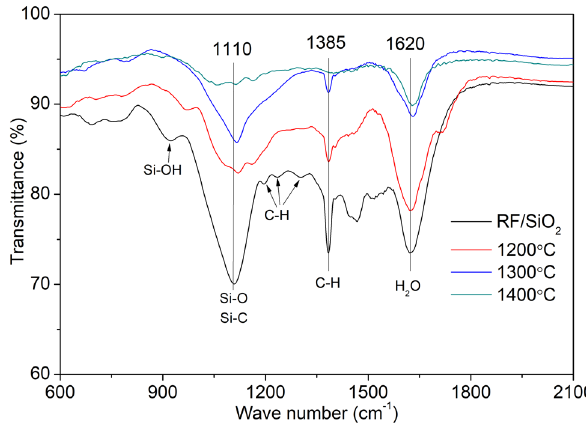
Figure 5: FTIR of C/SiO 2 composite aerogel before and after heat treatment.